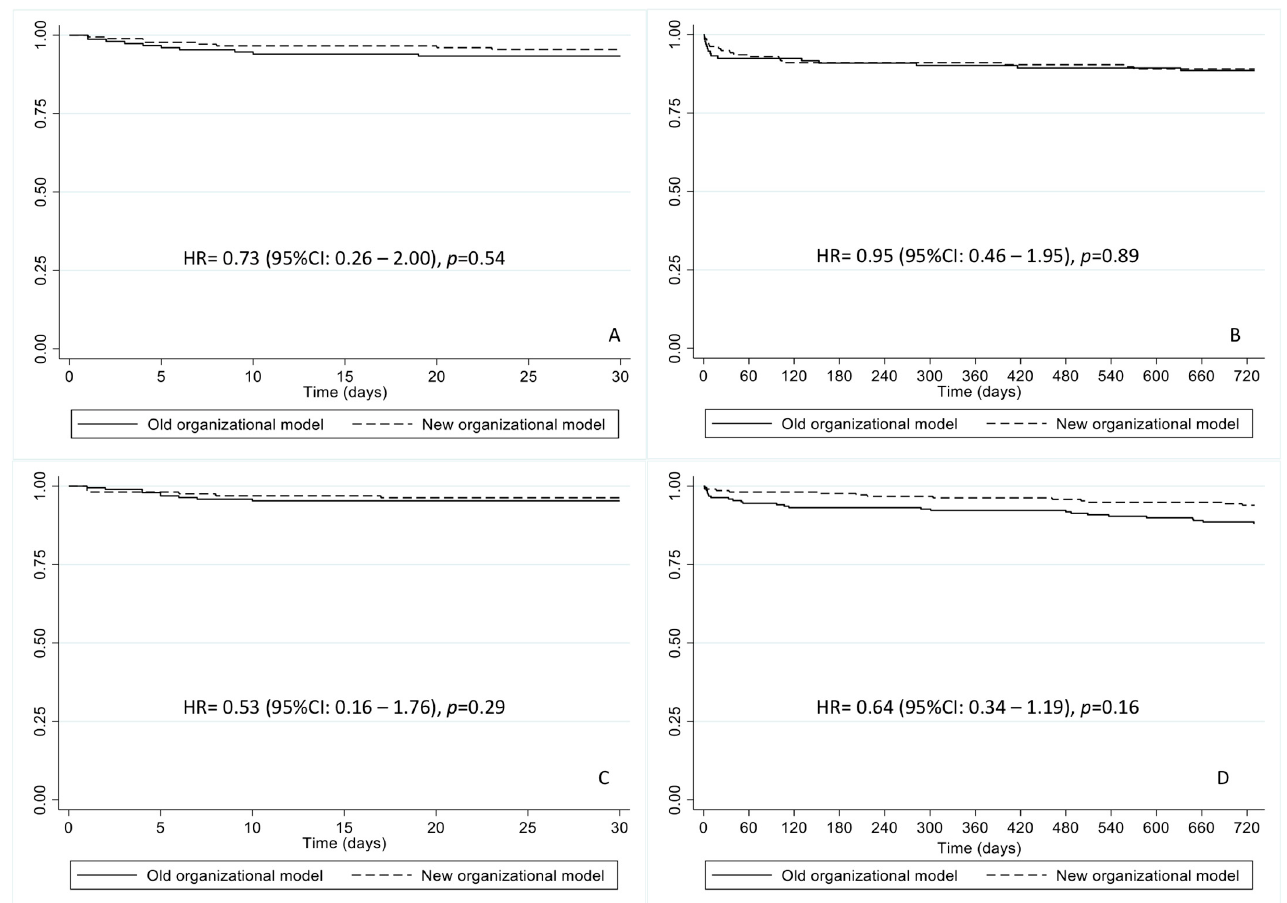
Figure 1. ( A ) 30-day survival for patients with a diagnosis of STEMI given in the Trento city territory. ( B ) 2-year survival for patients with a diagnosis of STEMI given in the Trento city territory. ( C ) 30-day survival for patients with a diagnosis of STEMI given elsewhere in the region. ( D ) 2-year survival for patients with a diagnosis of STEMI given elsewhere in the region. (HR = hazard ratio).